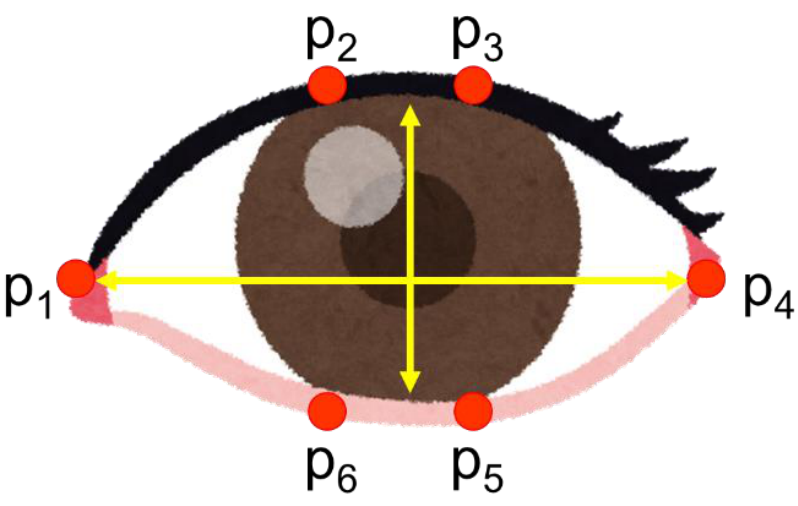
Figure 2. The feature points of the eye.